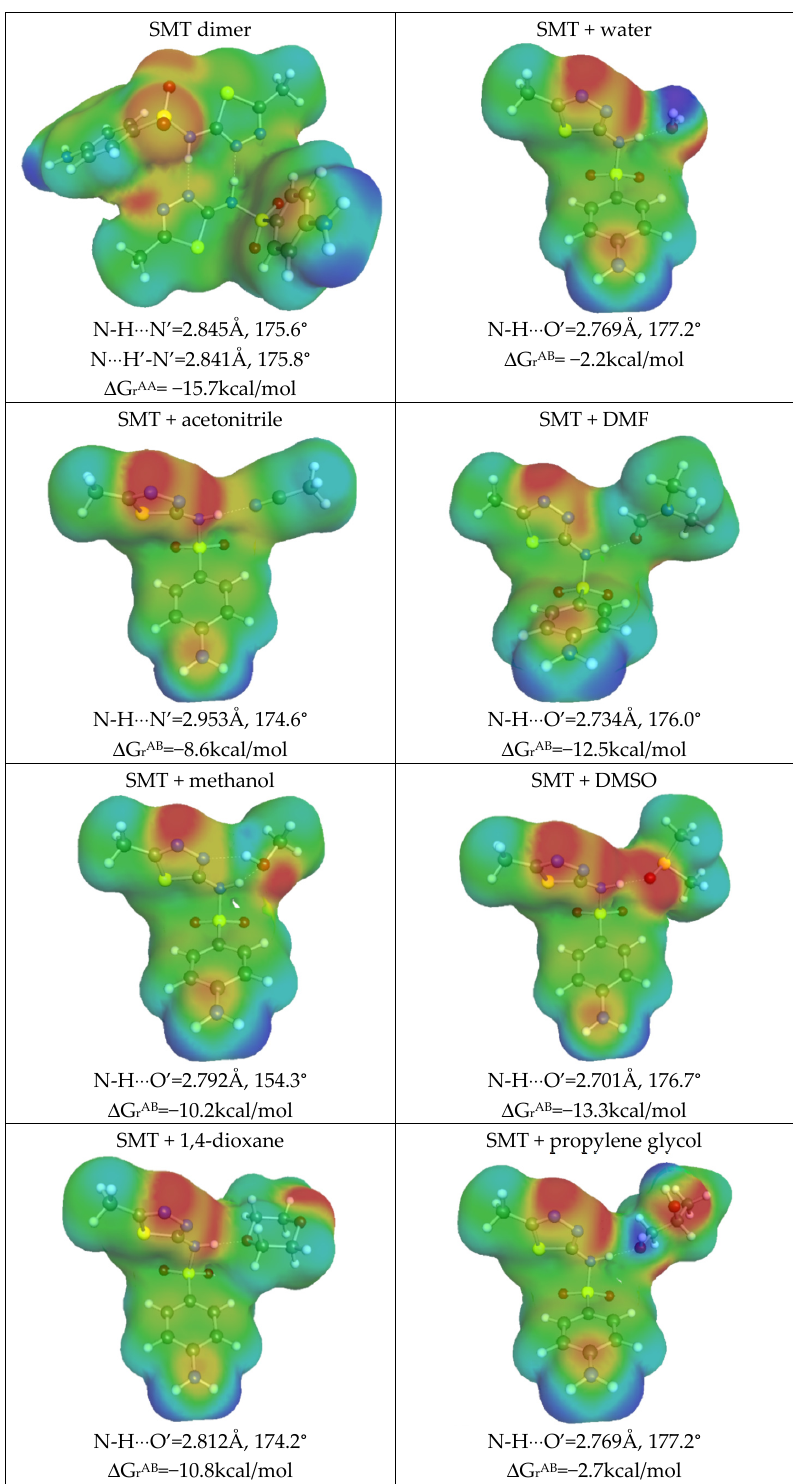
Figure 4. Schematic representation of structure and charge densities of the most stable pairs involving sulfamethizole in studied systems. Δ G r values represent concentration-independent pairs affinity commutated at the BP level.